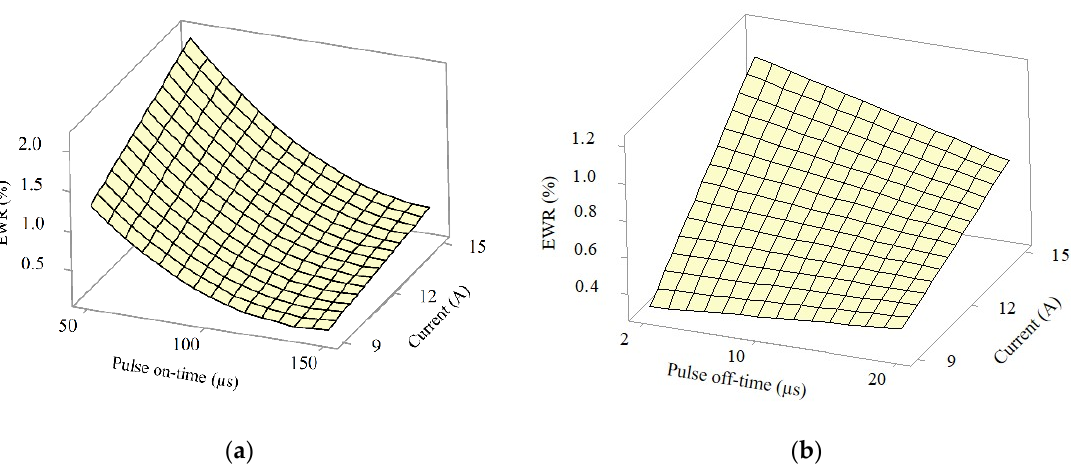
Figure 6. EWR sf as a function of: ( a ) pulse on-time and current, given pulse off-time = 10 µ s and electrode rotation = 35 rpm, ( b ) pulse off-time and current, given pulse on-time = 100 µ s and current = 12 A.